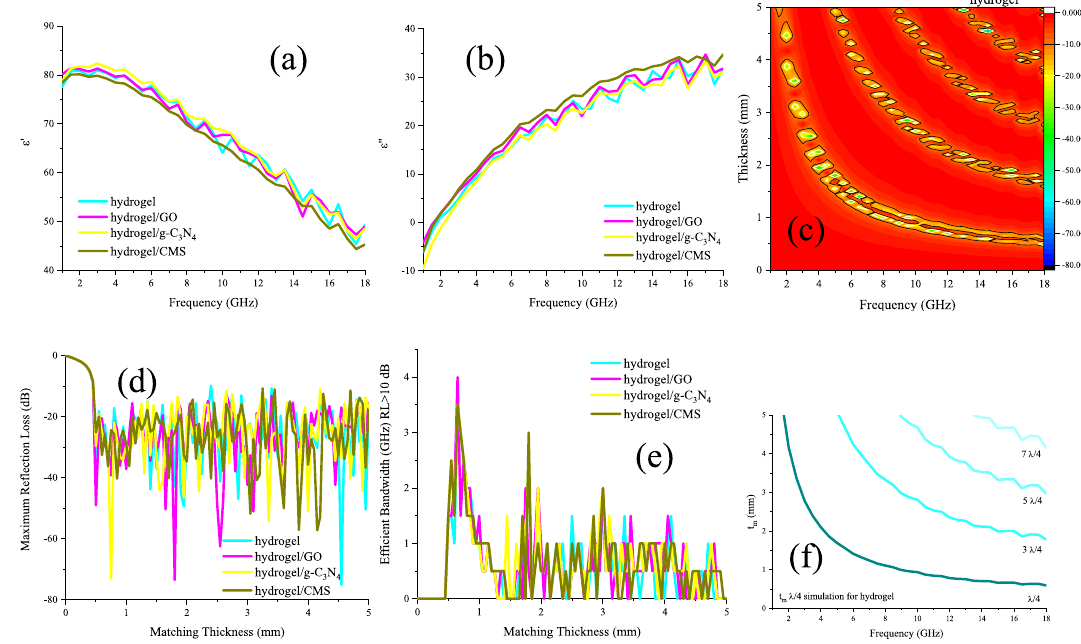
Figure 7. ε ′ ( a ), ε ″ ( b ), microwave absorption ( c ), maximum reflection loss versus matching thickness ( d ), efficient bandwidth (RL > 10 dB) versus matching thickness ( e ), and simulation of matching thickness ( f ) for the samples from 1 to 18 GHz.